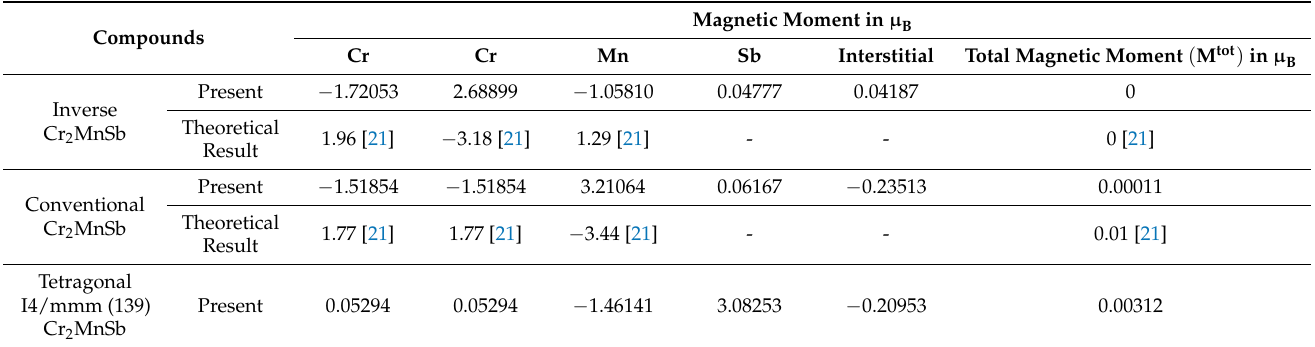
Table 4. Total magnetic moment for inverse, conventional and tetragonal I4/mmm (139) Heusler Cr 2 MnSb